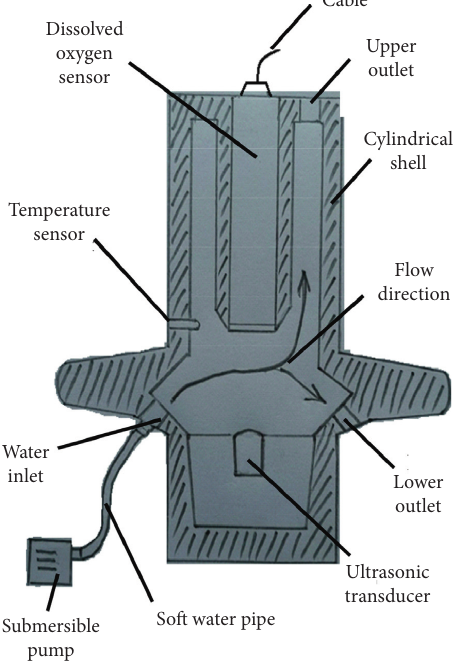
Figure 3: Sensor and self-cleaning